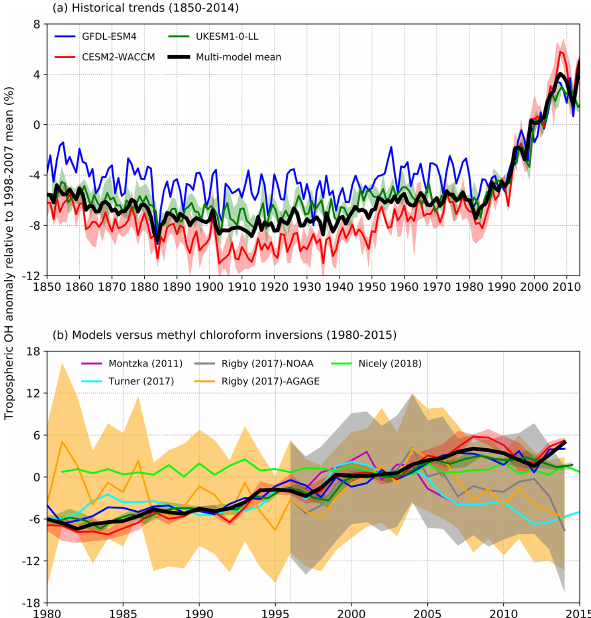
Figure 2. (a) Time evolution of global annual mean tropospheric OH (1850–2014) expressed as a percentage anomaly relative to the 1998–2007 mean (and ensemble spreads where available) for GFDL-ESM4 (blue), UKESM1-0-LL (green), CESM2-WACCM (red), and the multi-model mean (black). (b) Observation-based in- versions of global annual mean tropospheric OH for 1980–2015 from Montzka et al. (2011), Rigby et al. (2017), Turner et al. (2017), and Nicely et al. (2018), including ± 1 standard deviation uncertain- ties for the results from Rigby et al. (2017), with model results from (a)